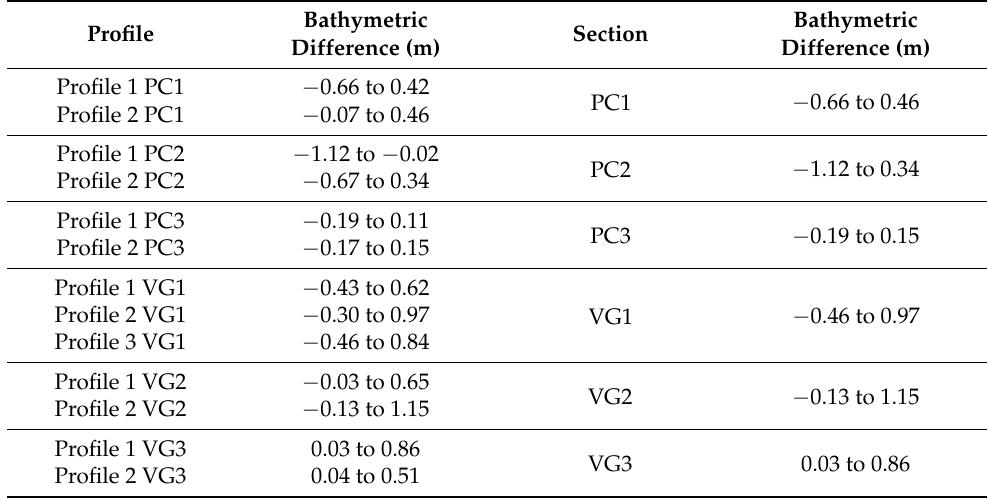
Table 5. Maximum and minimum values of differential bathymetry in each section.